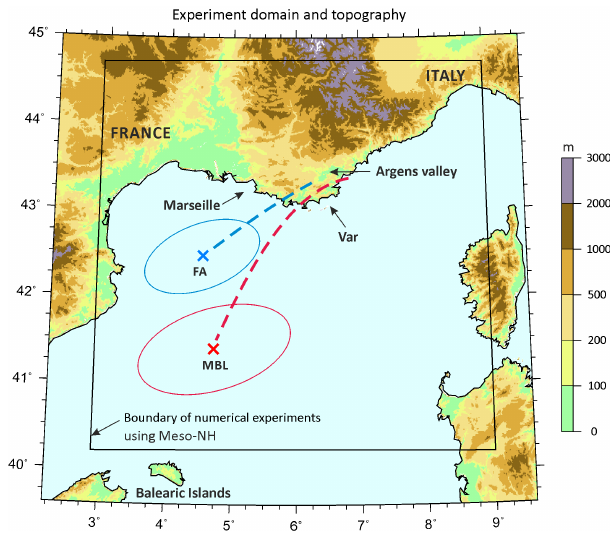
Figure 1. Topography and domain (black box) considered in nu- merical simulations using Meso-NH with a resolution of 2.5km. The centre location of the initial “sensitivity bubble” set in ma- rine boundary layer (MBL) and free atmosphere (FA) experiments is depicted by red- and blue-coloured cross marks, respectively, while the horizontal range of the initial bubbles is marked by an ellipse-shaped solid line of the same colour. The red dashed line in- dicates the horizontal projection of backward trajectories of some air parcels taken in the upper part of the convective systems of the eastern Var coast, and the blue dashed line depicts the horizontal projection of backward trajectories of some air parcels taken in the cold pool generated by the convective systems over the eastern Var